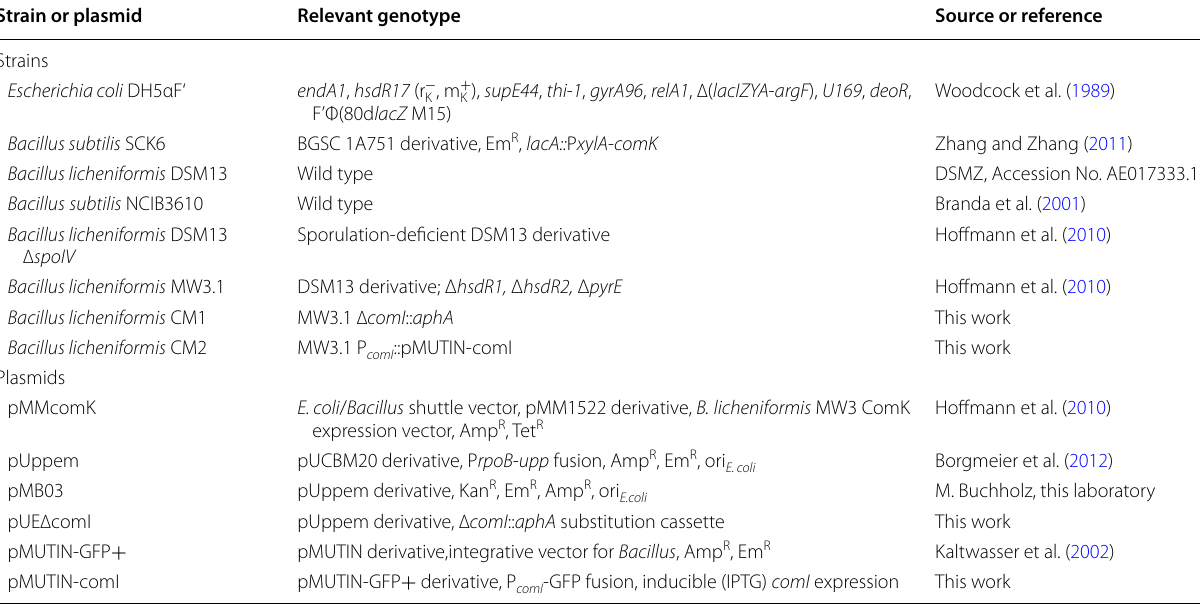
Table 1 Bacterial strains and plasmids Strain or plasmid Relevant